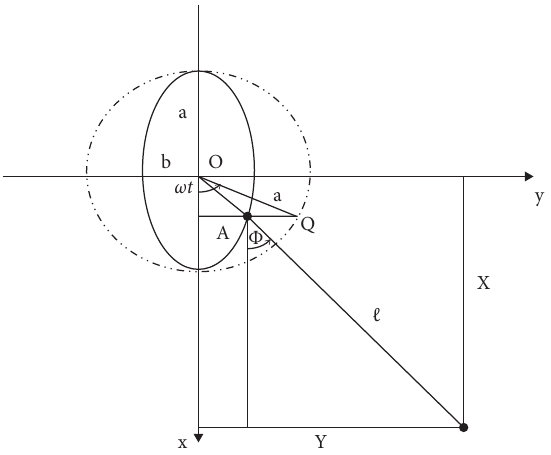
Figure 1: The pendulum motion on an